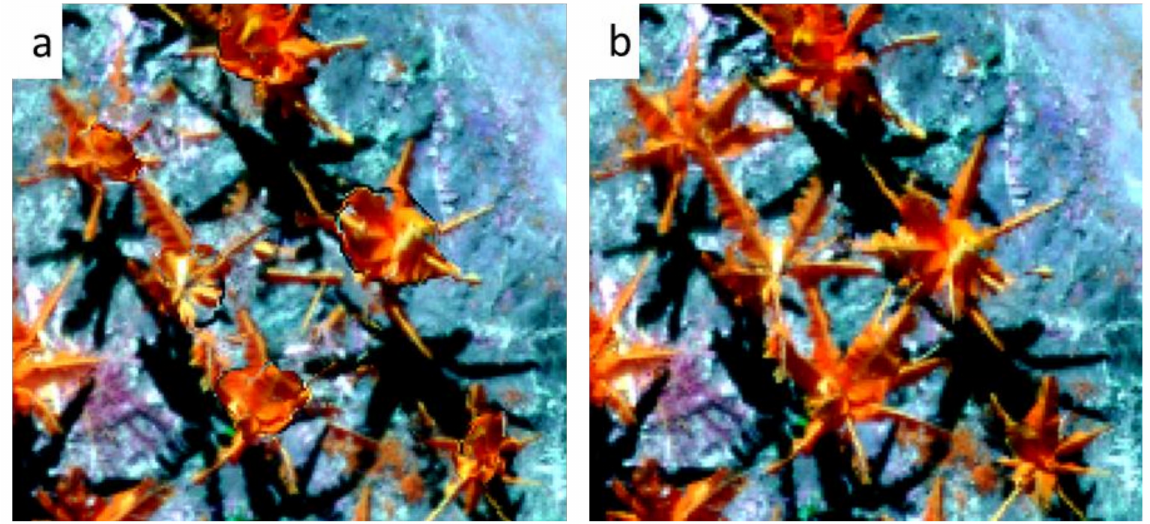
Figure 2. ( a ) Example of the halo effect occurring in the orthomosaic based on the DSM surface and ( b ) its absence in the orthomosaic generated using a DTM presented as false colour imagery (band 4 as red, band 1 as green, and band 2 as